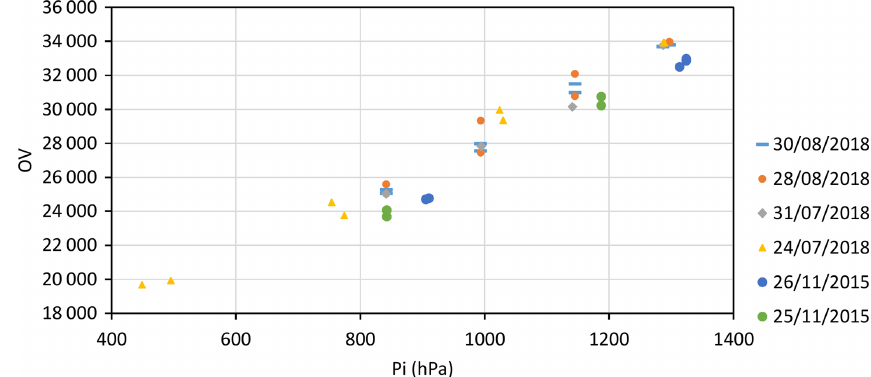
Figure 2. Results of the first and second sets of inlet pressure sensitivity tests. p i is the CRDS inlet pressure and OV is the aperture of the CRDS-cavity outlet valve.